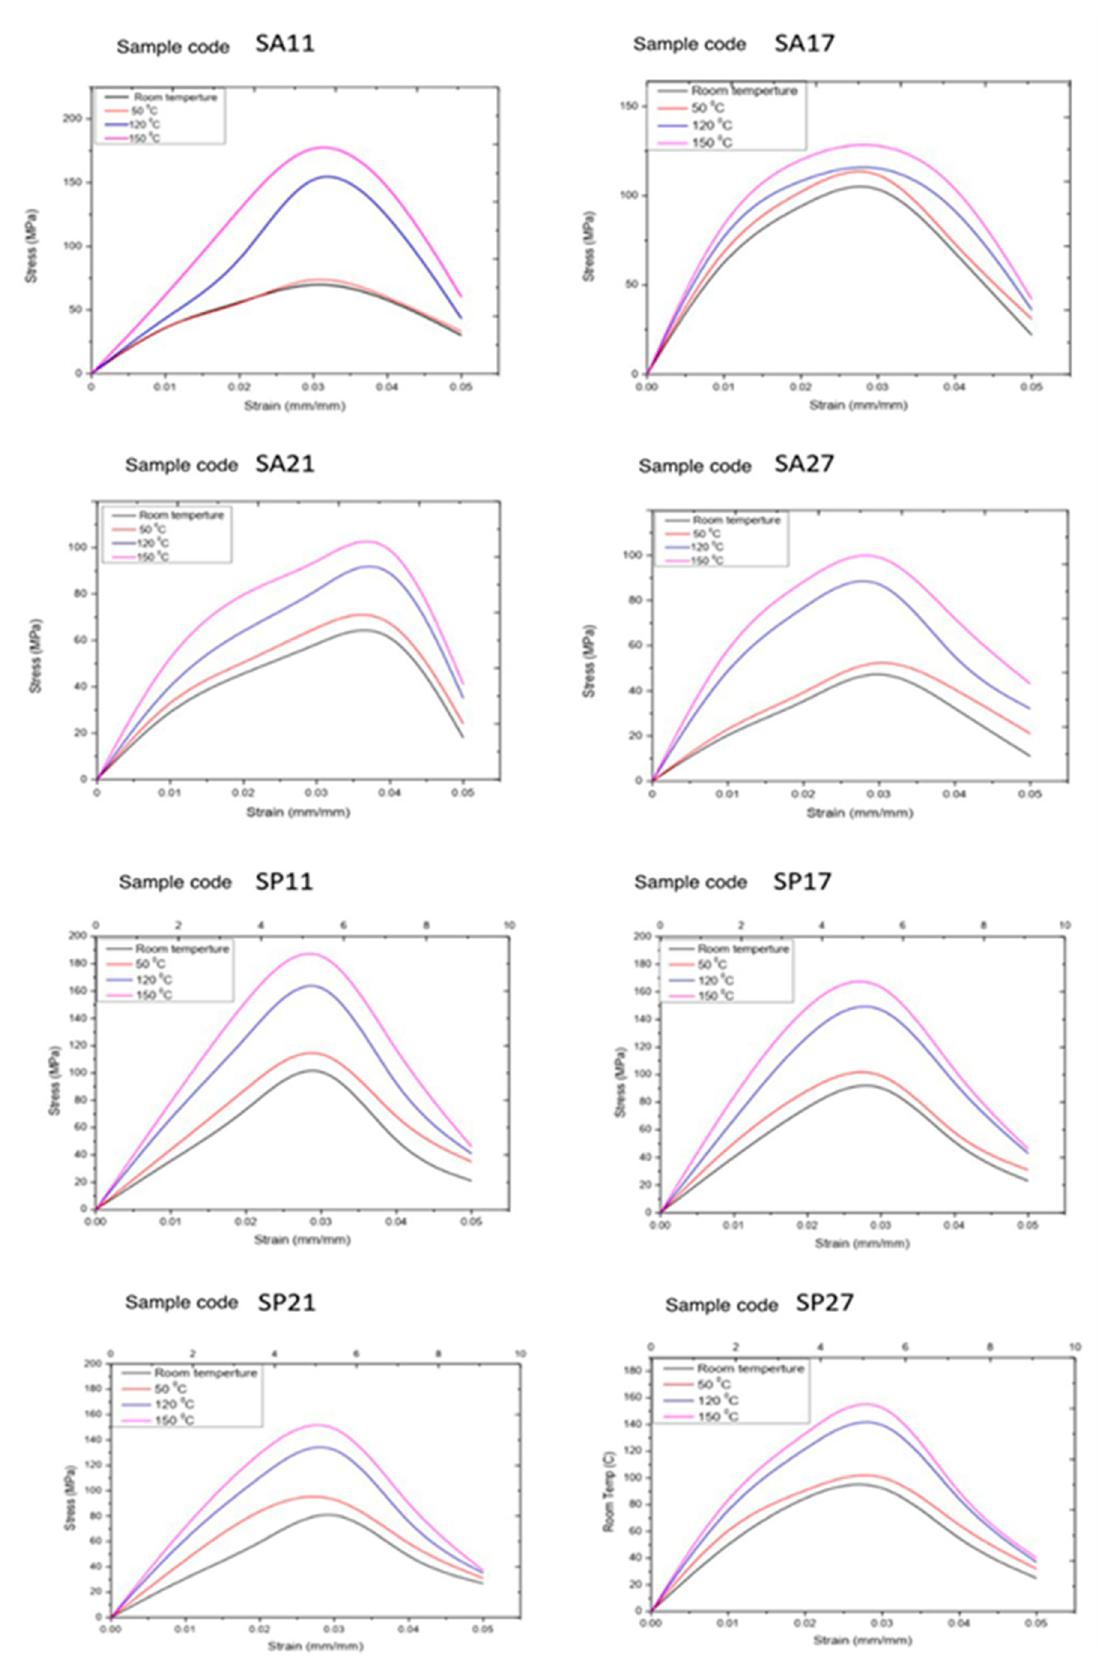
Figure A4. Tensile strength testing results of type A